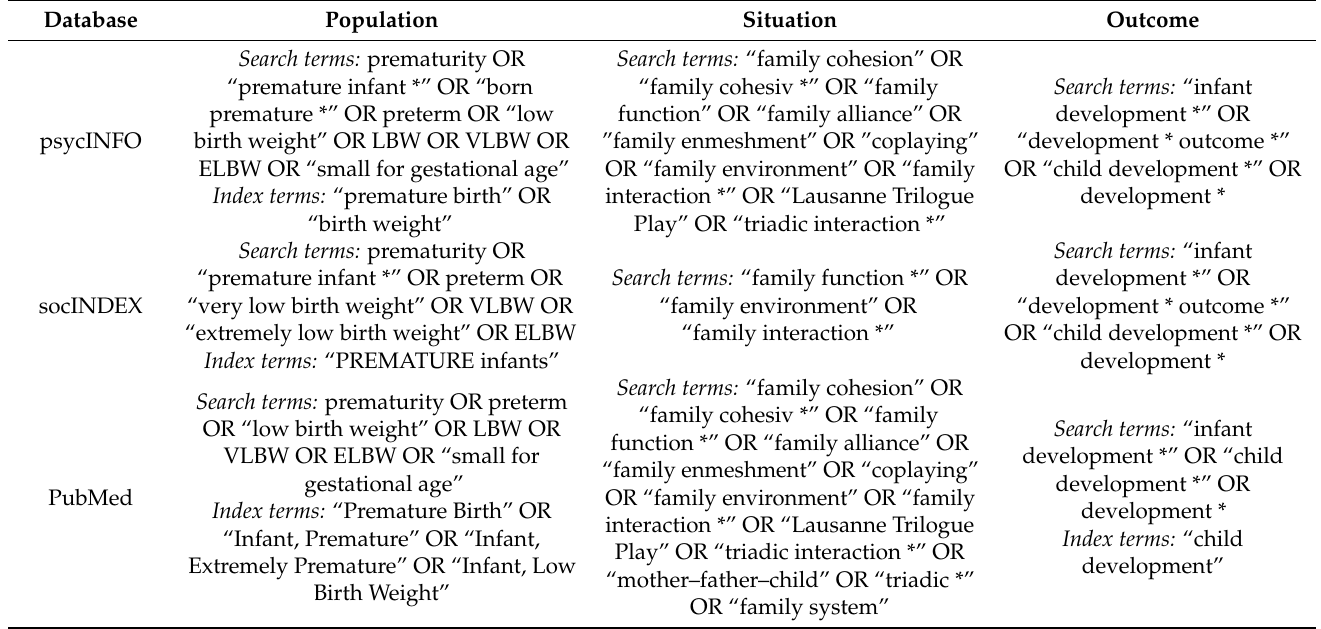
Table 1. Search terms used in each